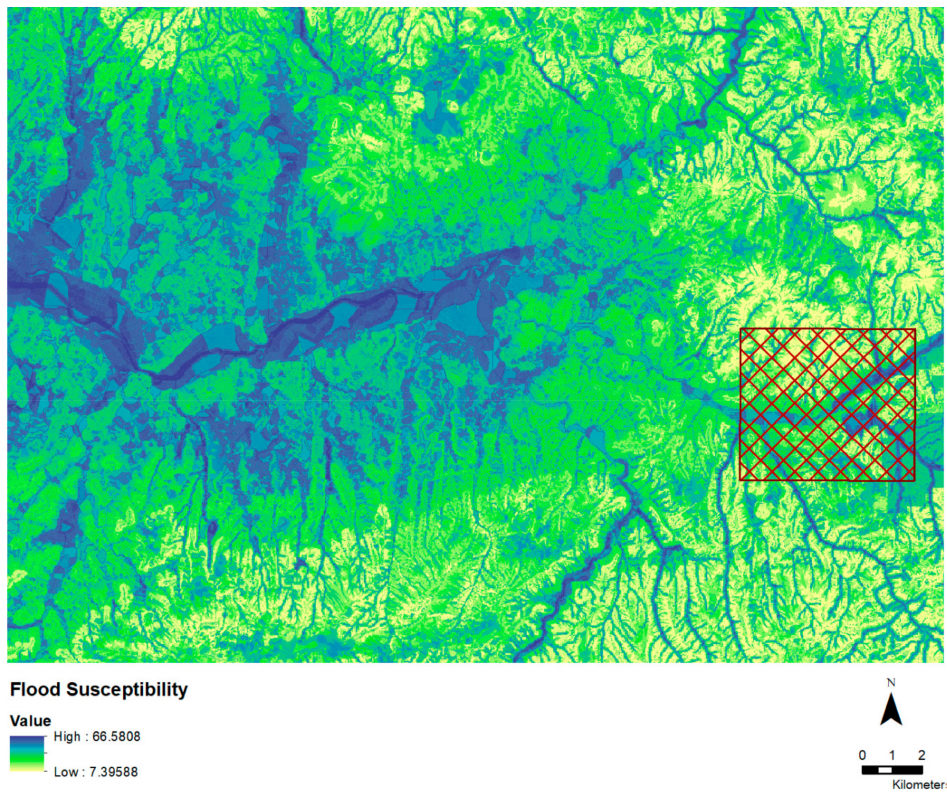
Figure 11. Flood susceptibility map produced by Sozer et al. [19] (the rectangular area to the east is the selected study area).